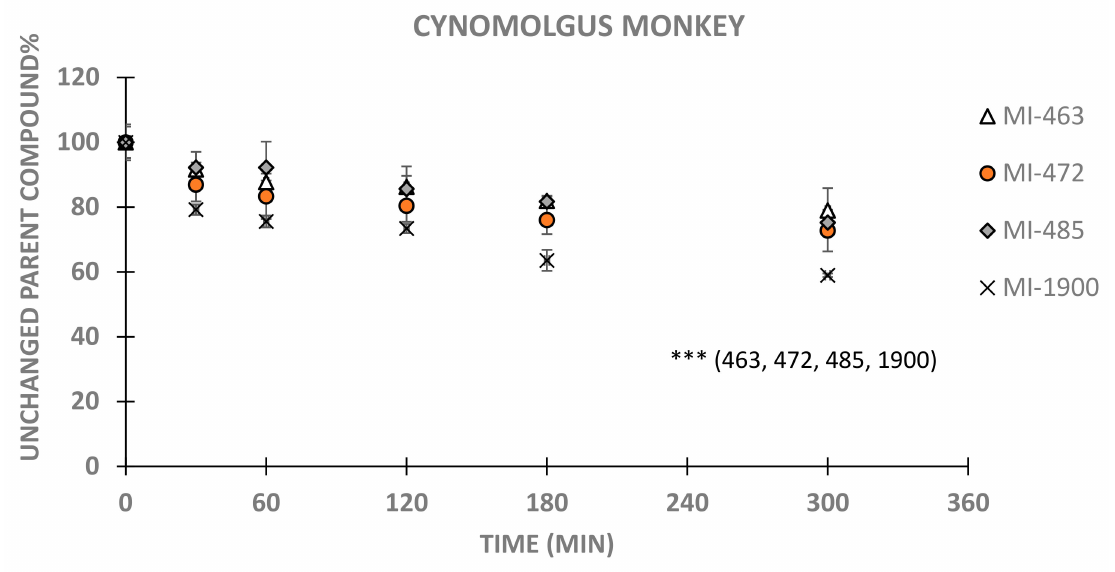
Figure 4. Time course of depletion of inhibitors MI-463, MI-472, MI-485 and MI-1900 in macaque primary hepatocytes (5 × 10 5 /mL) using 0, 30, 60, 120, 180 and 300 min sampling times. Relative percentage values of unchanged parent compounds were calculated by dividing the concentrations of the inhibitor measured at given time point by mean starting MI concentration in the treatment solution (mean ± SD; n = 3–9/group). Asterisks indicate significant differences compared to starting values of the indicated inhibitors in parentheses (*** p <